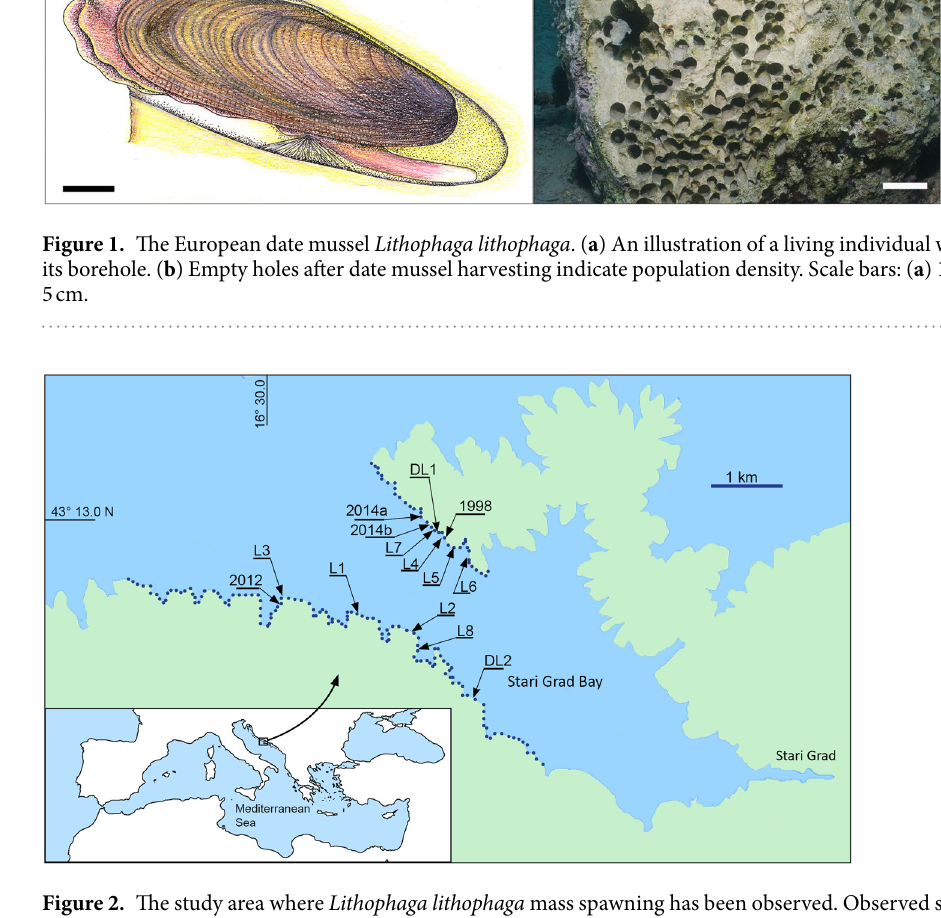
Figure 2. The study area where Lithophaga lithophaga mass spawning has been observed. Observed spawning locations include the preliminary observations made in 1998, 2012 and 2014 and the systematic observations made in 2015 (locations L1–L8). The dotted lines indicate the extent of the coastline inspected twice each day during the systematic observations made in 2015. DL: location of temperature data loggers. Maps were